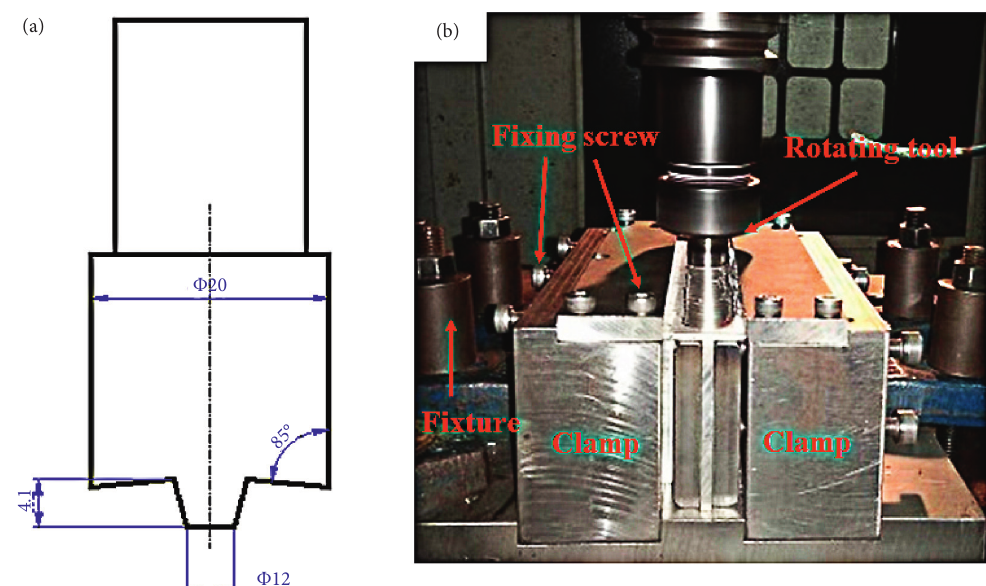
Figure 2: (a) Schematic drawing of the welding tool (in mm). (b) Actual picture of welding process.